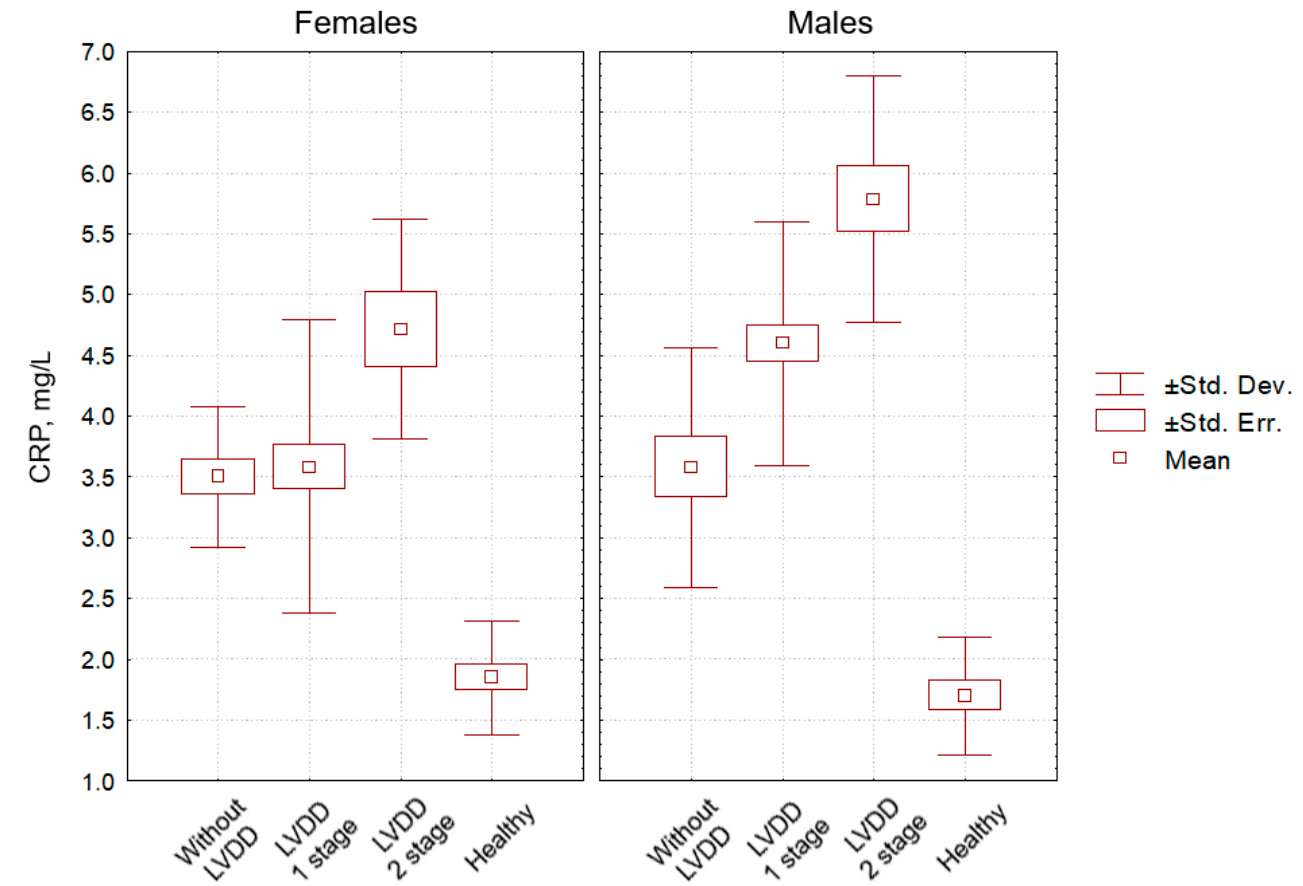
Figure 3. Indicators of CRP level in the blood (mg/L) in patients with hypertension without CHF and LV diastolic dysfunction (comparison group), patients with hypertension with CHF and LV diastolic dysfunction of the 1st and the 2nd stages, and healthy individuals (control group), taking into account participants’ gender.